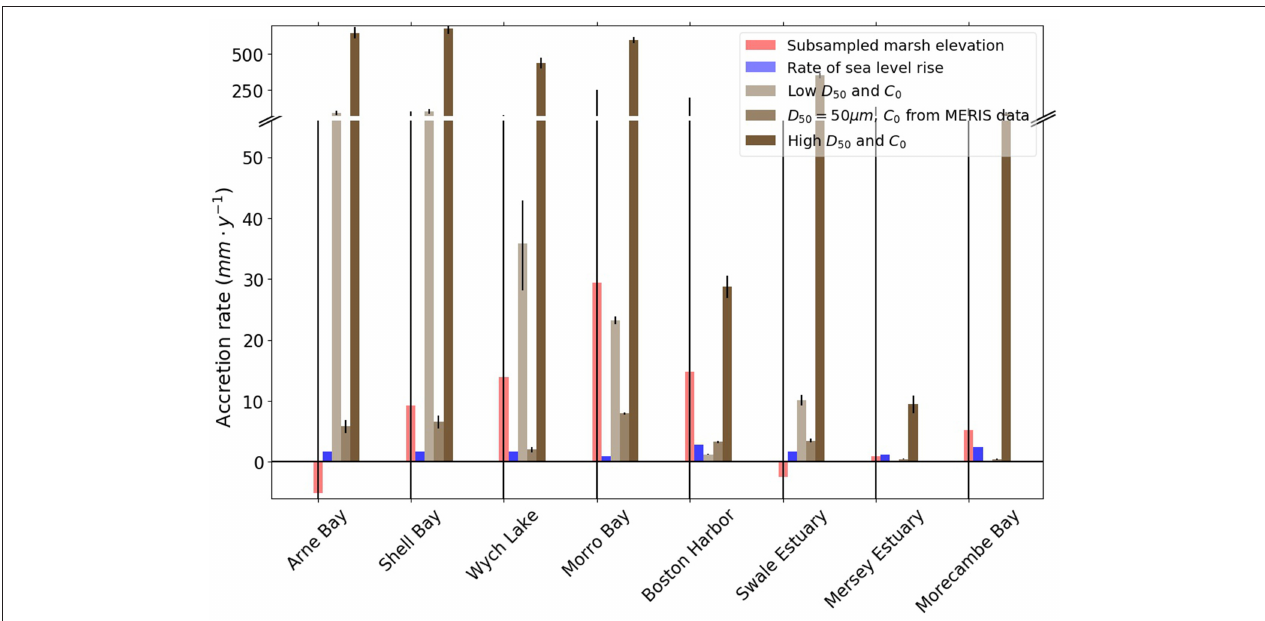
FIGURE 6 | Magnitude of deposition rates (red and brown bars), with relative sea level rise RSLR for reference, for each site; the initial elevation is the normalized dominant elevation of the platform z max ( f . Black lines indicate vertical Z )